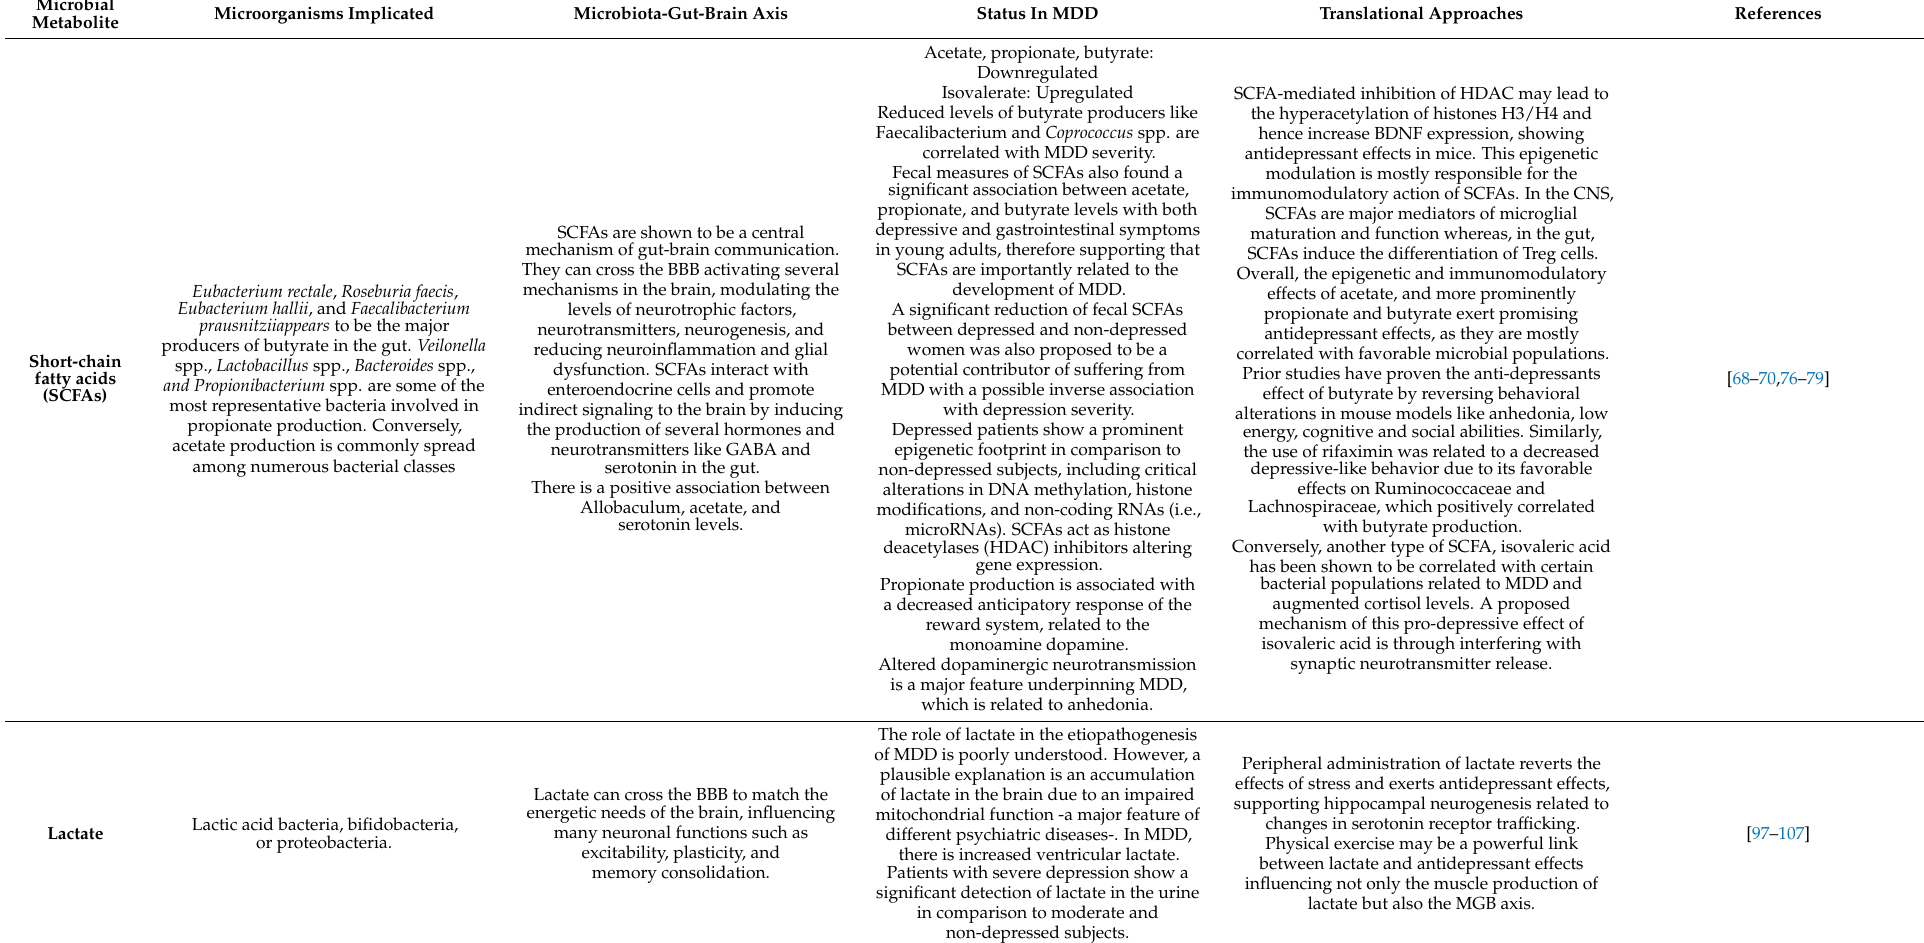
Table 1. Summarized results reviewed in this